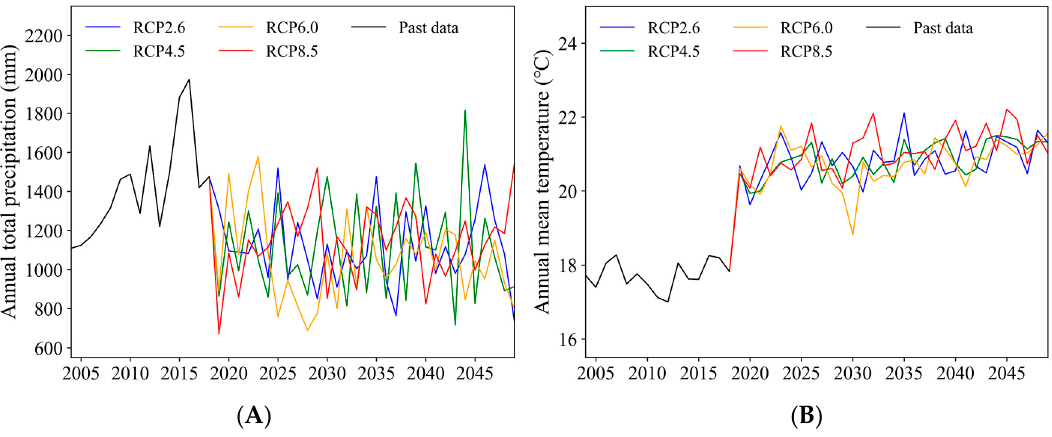
Figure 15. The annual total precipitation ( A ) and annual mean temperature ( B ) of Anji County under different climate scenarios from 2004 to 2049.